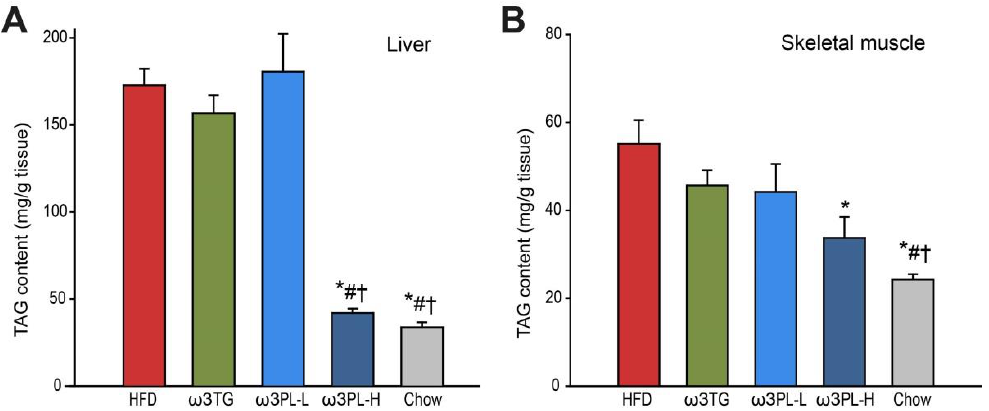
Figure 2. The effect of long-term Omega-3 supplementation on ectopic fat accumulation in dietary obese mice. After 8 weeks of dietary interventions, the level of TAG accumulation was assessed in the liver ( A ) and skeletal muscle ( B ). Data are means ± SEM ( n = 8). *, significantly different vs. HFD; #, significantly different vs. ω3TG; †, significantly different vs. ω3PL-L, ( p < 0.05, one-way ANOVA).